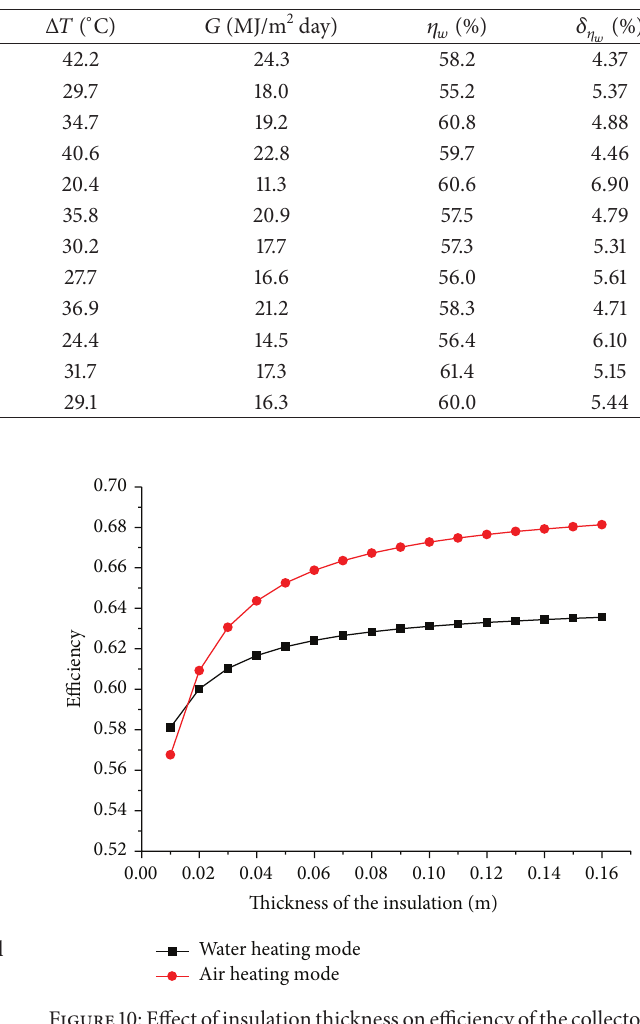
Figure10:Effectofinsulationthicknessonefficiencyofthecollector in two working